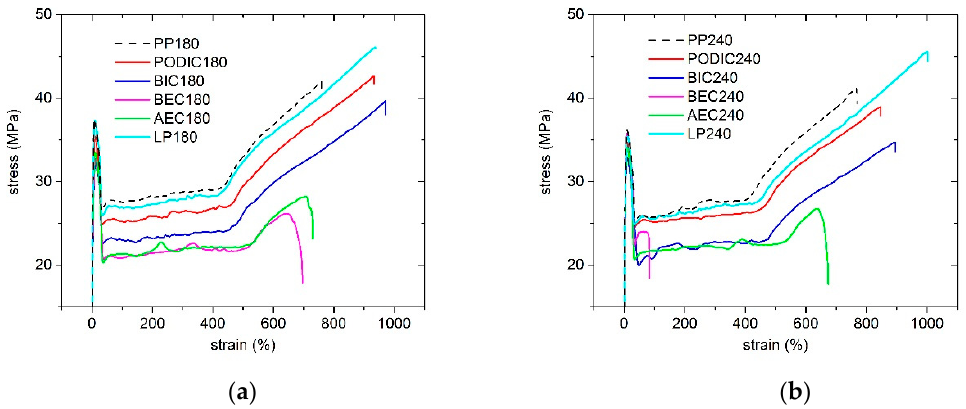
Figure 11. Stress–strain plots of unmodified PP and modified PP extruded at ( a ) 180 °C and ( b ) 240